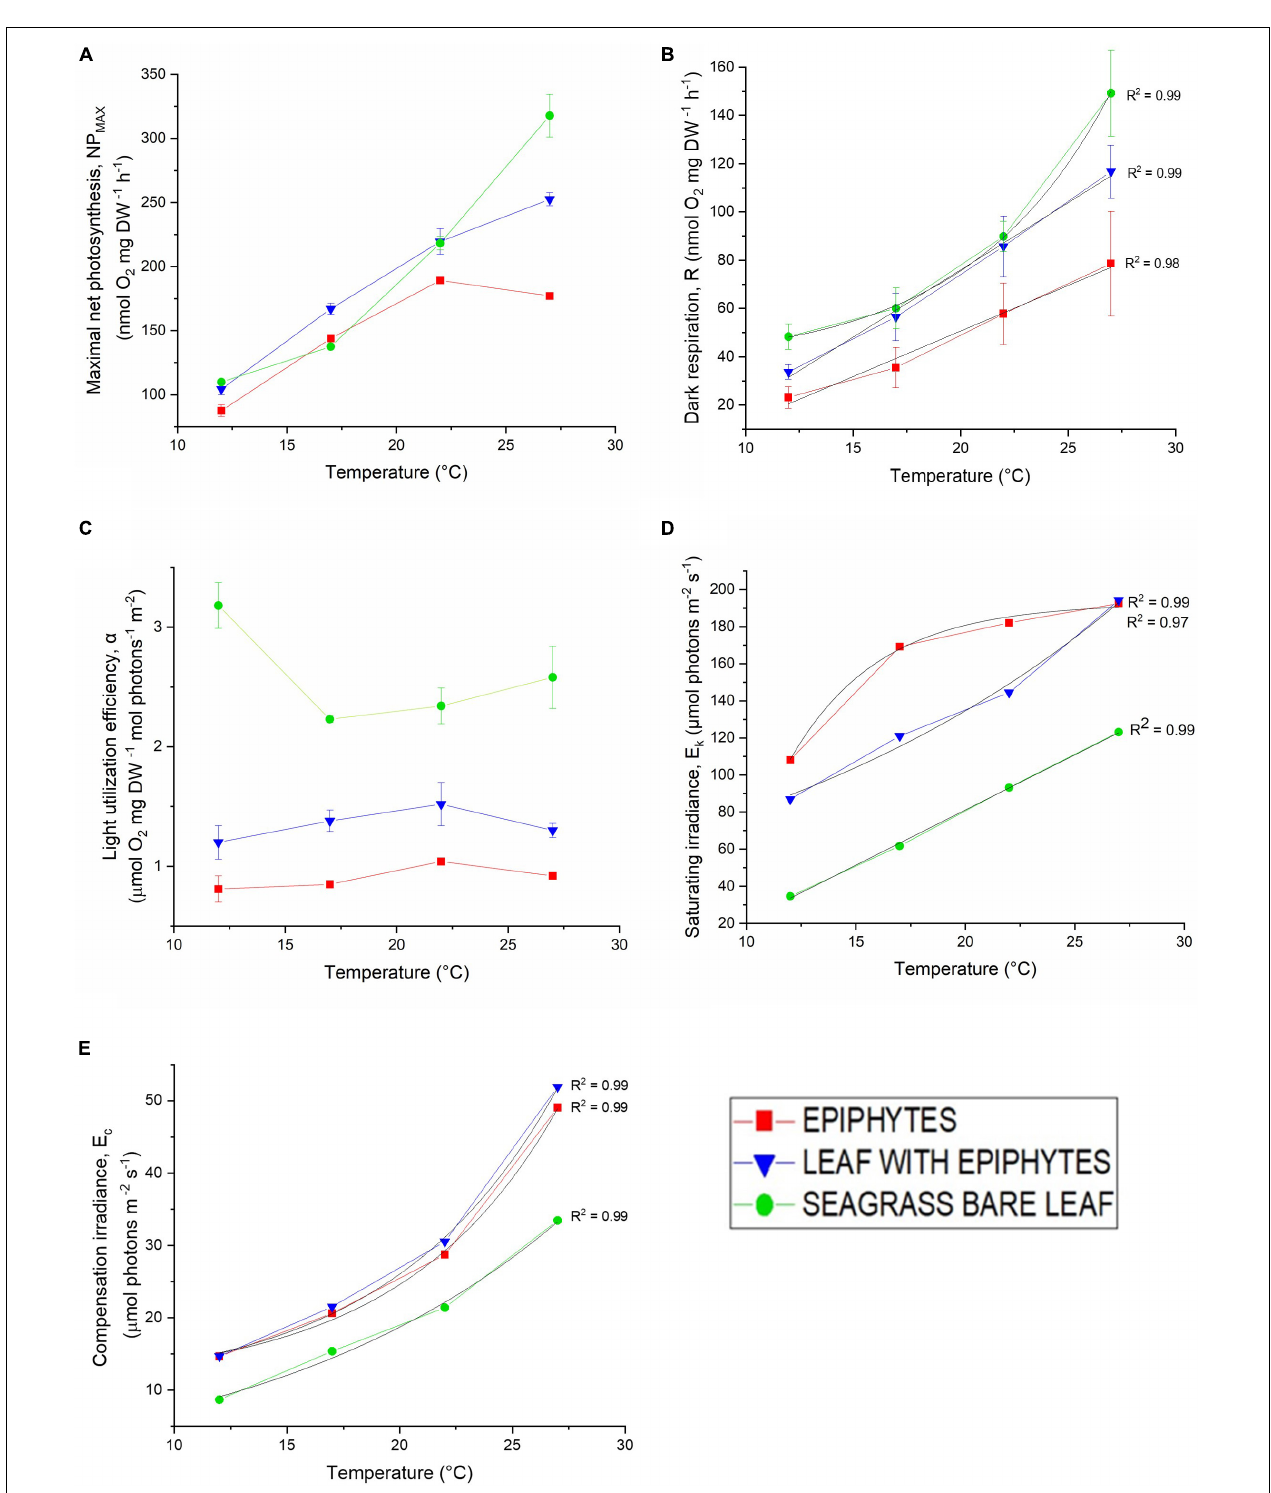
FIGURE 2 | (A) Maximum photosynthesis rate ( Pmax ), (B) dark respiration ( R ), (C) light use efficiency ( α ), (D) photon scalar irradiance at the onset of photosynthesis saturation ( E k ), and (E) compensation photon scalar irradiance ( E c ) as a function of increasing temperature (12, 17, 22, and 27 ◦ C). Red symbols and lines represent epiphytes originating from Z. marina L. leaves. Blue symbols and lines represent Z. marina L. leaves with epiphytes. Green symbols and lines represent bare Z. marina L. leaves. Black lines show fitted exponential or linear function for the photosynthetic parameters: R, E c and E k ; all with R 2 ≥ 0.97. Symbols with error bars represent mean values ± SEM; n = 4, biological replicates.